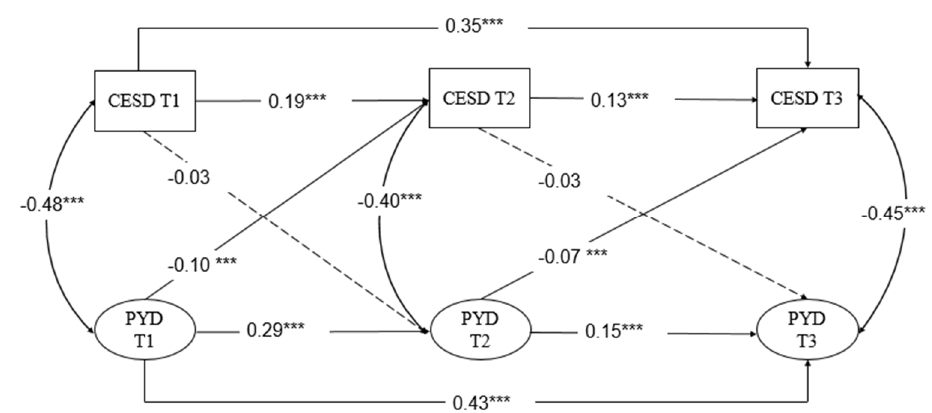
Figure 2. Cross-lagged relationship between positive youth development (PYD) and depressive symptoms across three waves. T1, Time 1 (first year); T2, Time 2 (second year); T3, Time 3 (third year). Note. *** p <